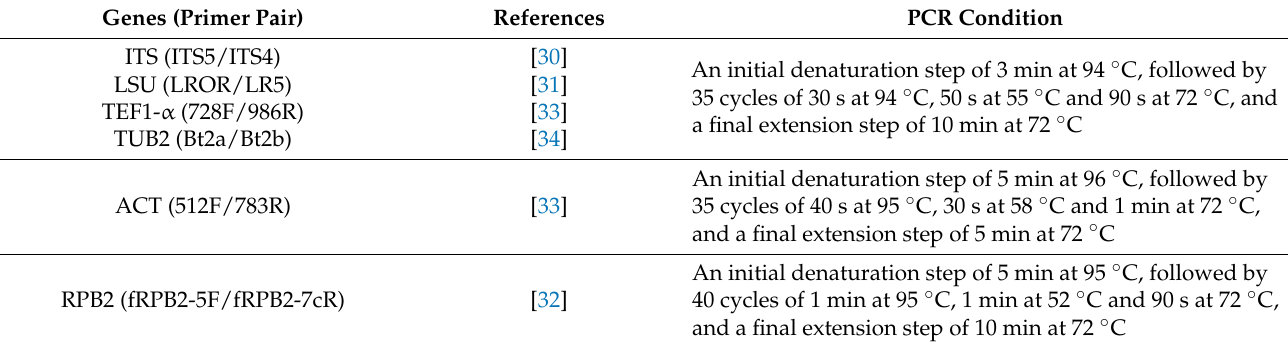
Table 1. Partial marker regions, primers and PCR conditions used in this study.